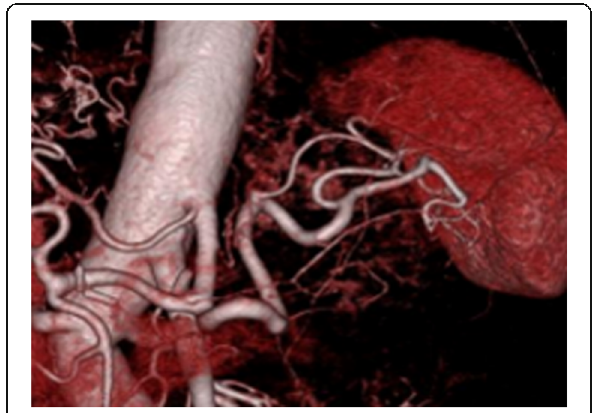
Fig. 5 3D-CT angiography to evaluate the formation of the vessels at the hilum of the